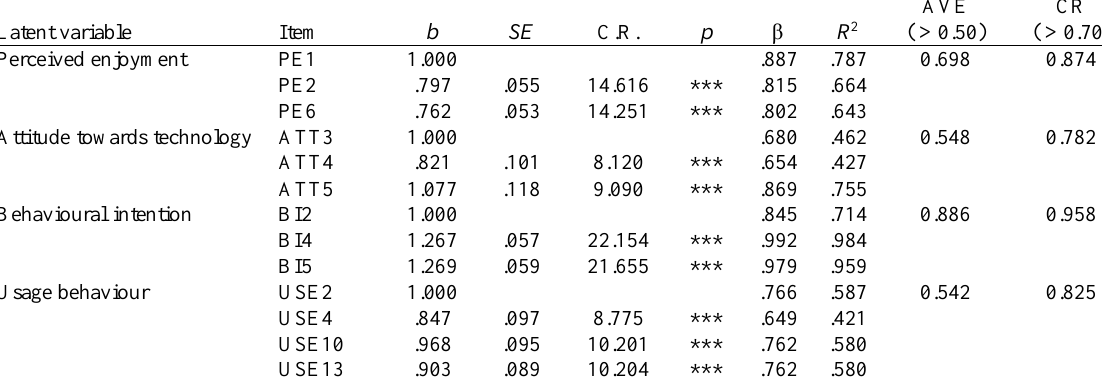
Table 2 Results for the measurement